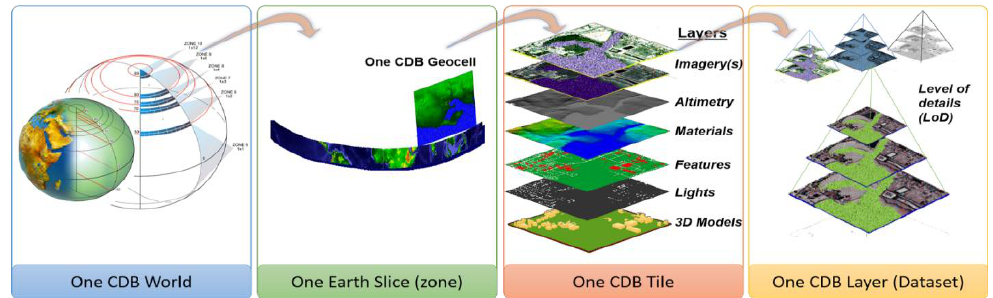
Figure 3. The OGC CDB data organization structure.